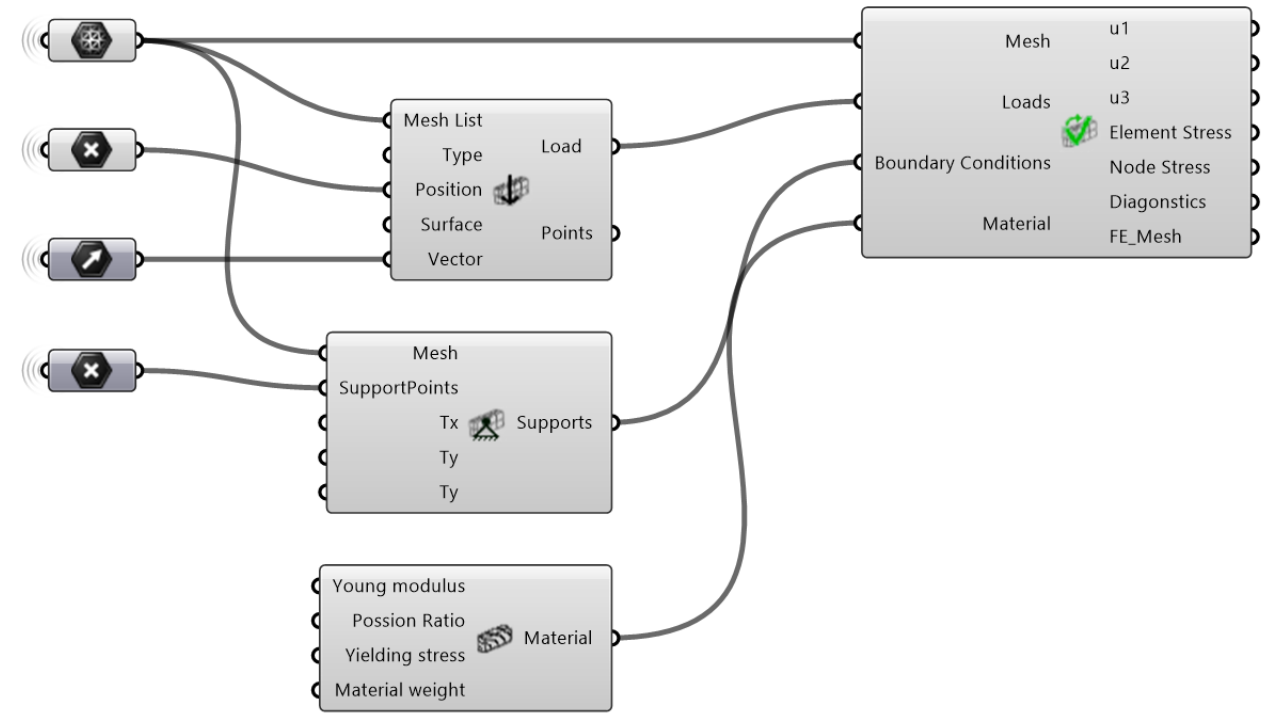
Figure 7. Necessary components for establishing an FEA. The left column represents containers for native Rhino geometry, the middle column the components for creating loads and supports, while the right component assembles and analyses the mode.